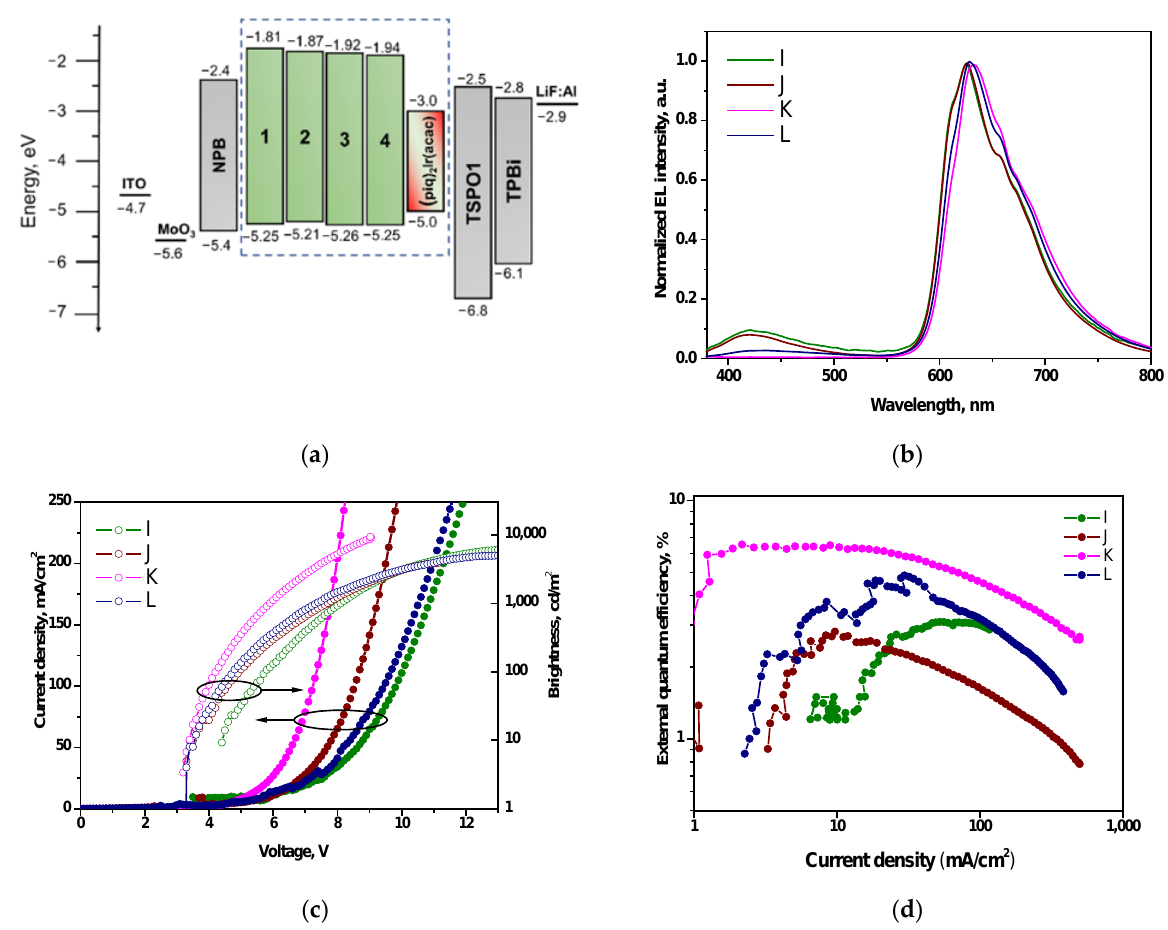
Figure 6. Diagram of energy levels of OLEDs I-L ( a ); electroluminescence spectra of OLEDs I-L recorded at applied voltage of 10 V ( b ); current density and luminance versus voltage plots ( c ); external quantum efficiency versus brightness plots ( d ). Arrow denotes the correspondence of data to axis.